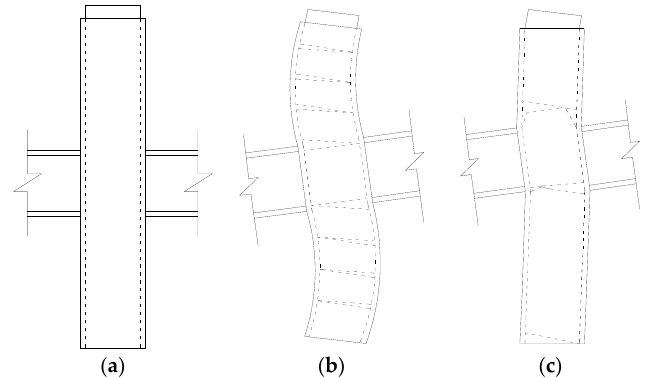
Figure 1. Tianjin 117 super high rise building. ( a ) Tianjin 117 under construction; ( b ) Brace in Tianjin 117 building.